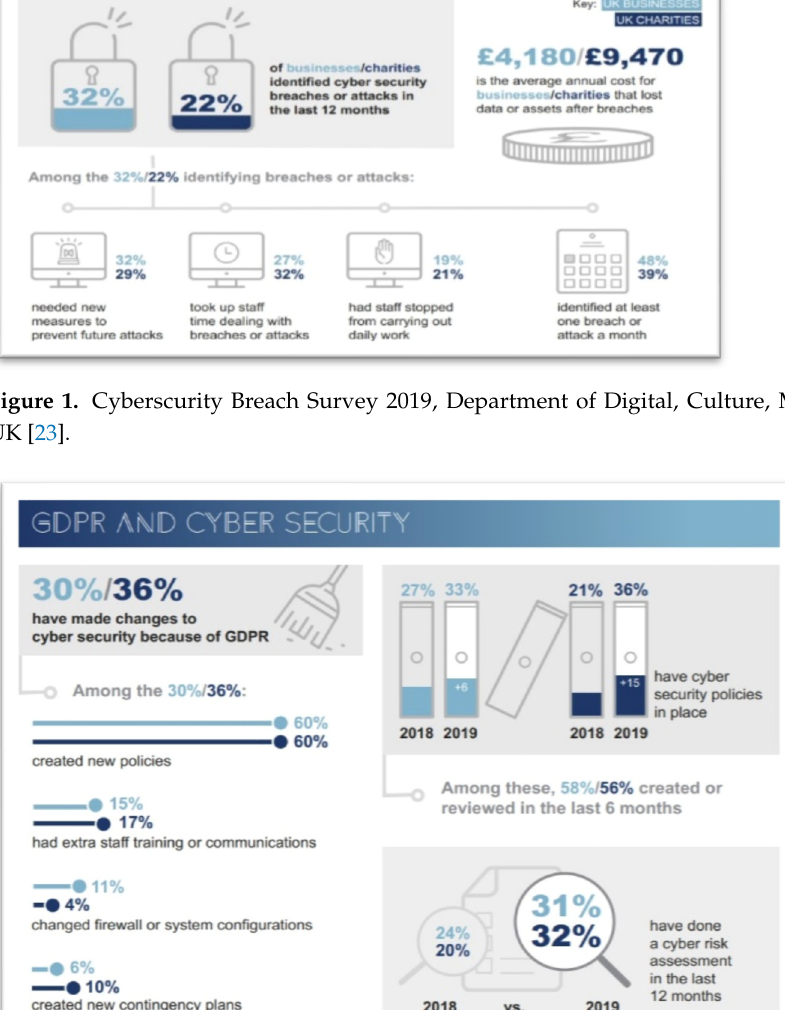
Figure 1. Cyberscurity Breach Survey 2019, Department of Digital, Culture, Media, and Sports UK [23].